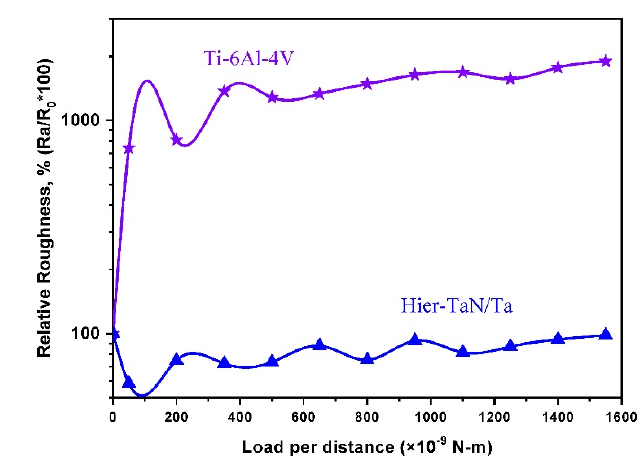
Figure 7. Relative roughness as a function of load per distance traveled obtained on the Ti6Al4V substrate and Hier-TaN/Ta coating. Values close to 100% indicate a low roughness modification in comparison to the virgin surface before the tribological test.